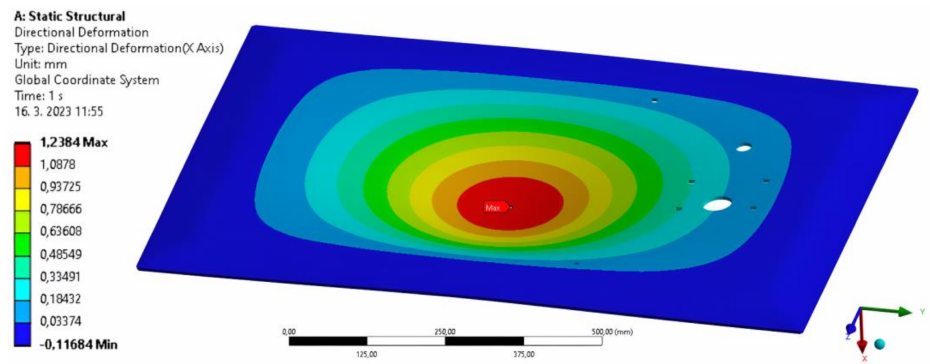
Figure 16. Results of the permanent redesign deformation